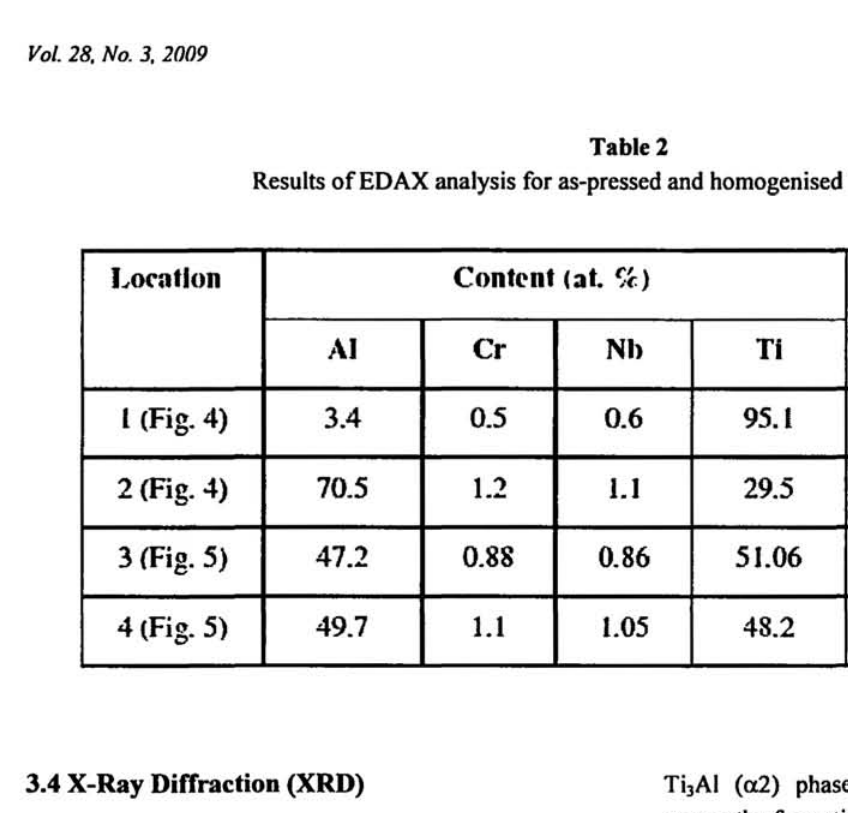
Results of ED AX analysis for as-pressed and homogenised TACN samples